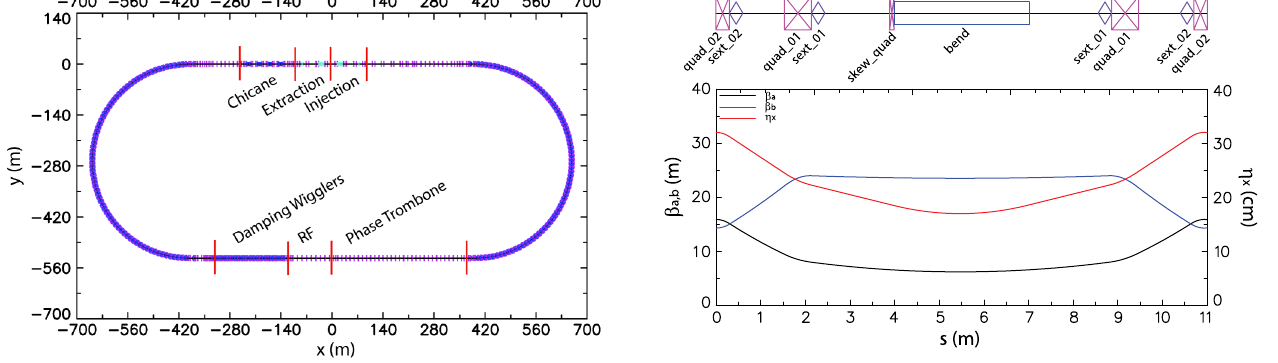
FIG. 1. Layout of DTC04 lattice.